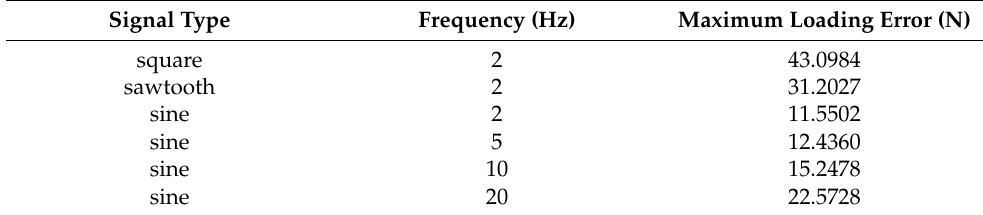
Table 2. System control error without interference.